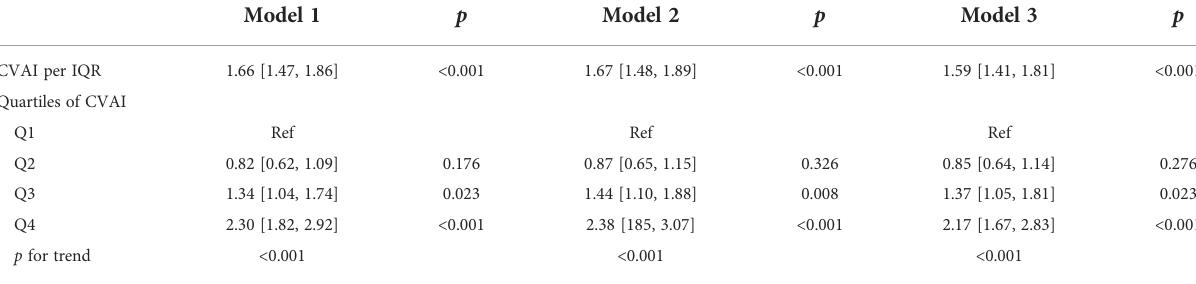
TABLE 2 Association of CVAI with the risk of T2DM in the